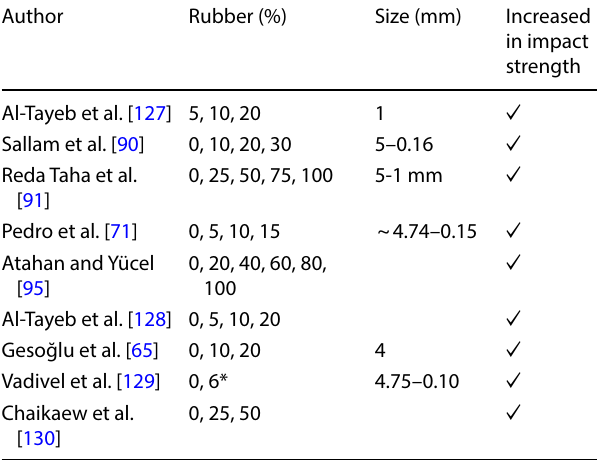
* Sign shows rubber inclusion by weight